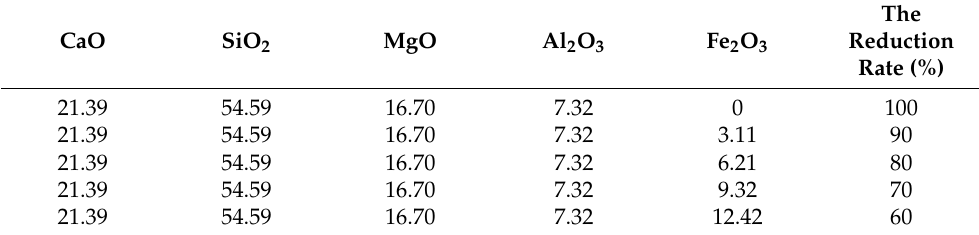
Table 2. Compositions of the base glasses